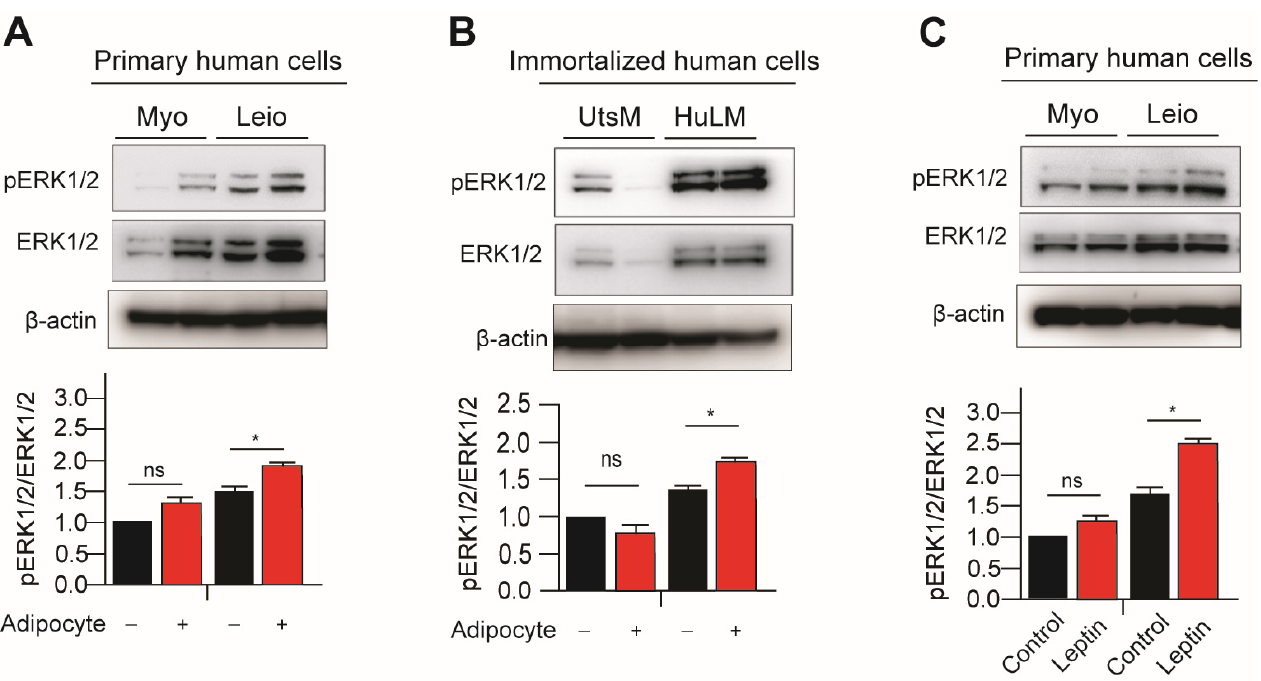
Figure 2. Leptin treatment and adipocyte coculture activates ERK1/2 signaling in myometrium and leiomyoma cells. For eight days, the immortalized and primary leiomyoma and myometrium cells underwent adipocyte coculture. Half of the medium was replaced with fresh medium every other day. After 8 days, we prepared cell lysates from the cultured cells, both with and without adipocyte coculture. Western blotting was used to analyze phosphorylated ERK1/2/total ERK1/2 protein ratios in ( A ) primary and ( B ) immortalized cells. The same Western blot membrane was probed for pSTAT3/total STAT3 and pERK1/2/total ERK1/2, presented in Figures 1 and 2, respectively. There- fore, the same loading control β -actin was used for all of them. Primary human myometrium and leiomyoma cells were treated with 100 ng/mL leptin for 48 h, and Western blotting was used to analyze phosphorylated ERK1/2/total ERK1/2 protein ratios ( C ). The mean ± SEM was determined from three independent experiments. *, p < 0.05 vs. the single cell type culture; ns, non-significant.